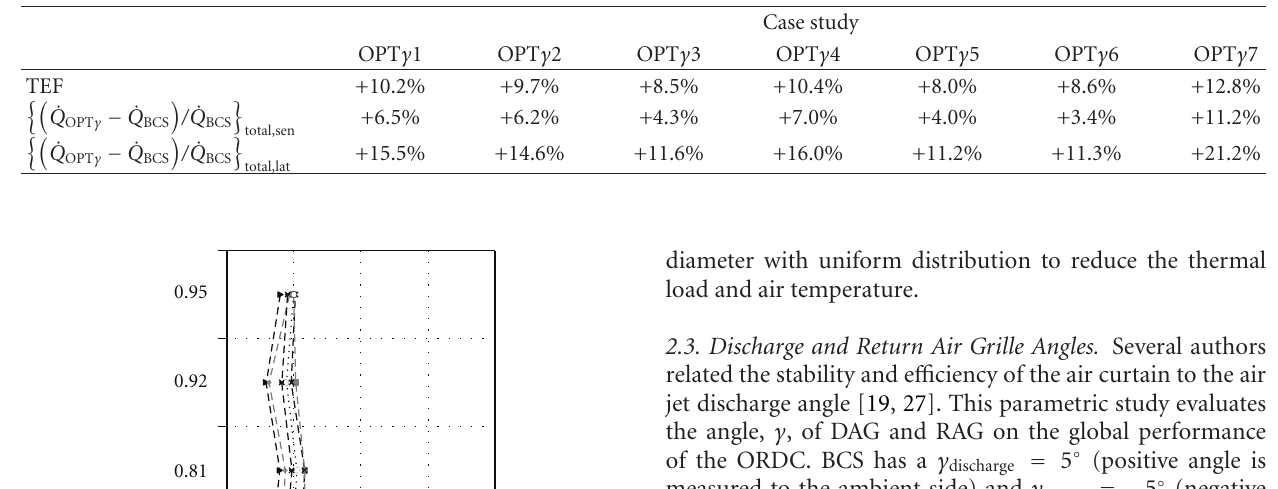
Table 9: Thermal and temperature ratios relatively to BSC—grille angles parametric study.